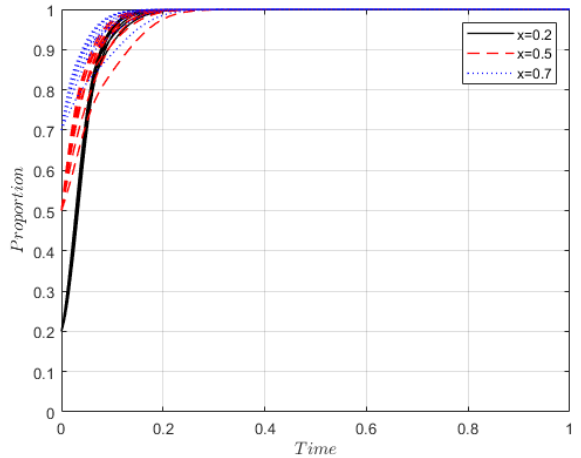
Figure 9. Evolutionary diagram when x differs.